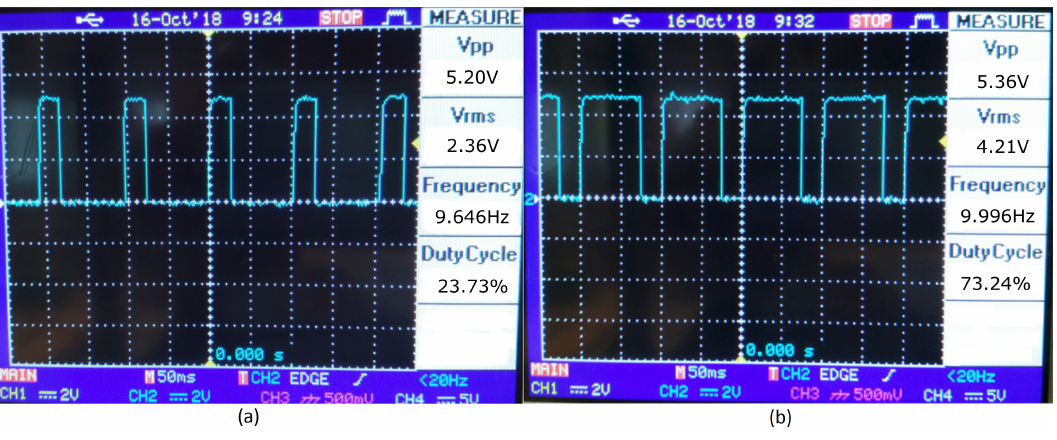
Figure 6. Recorded encoder output. ( a ) Motor clockwise (CW) rotation. ( b ) Motor counter-clockwise (CCW) rotation. The output from the sensor always gives approximately a 25% or 75% duty cycle from the CW or CCW regardless of the speed. Table 1. Information from the encoder